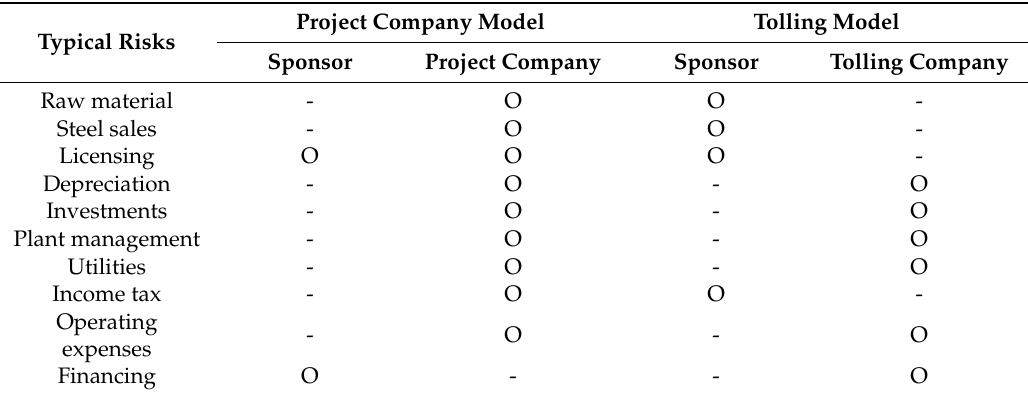
Table 1. Responsibility matrix (modified from